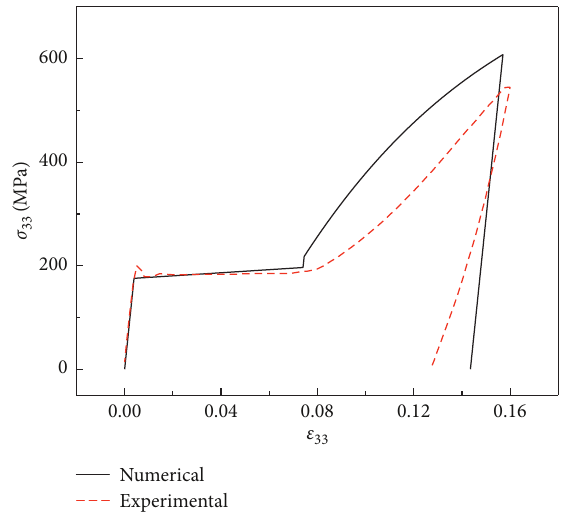
Figure 6: Experimental and simulated σ − ε tensile curves of NiTiNb SMA sample at − 60 ° C.